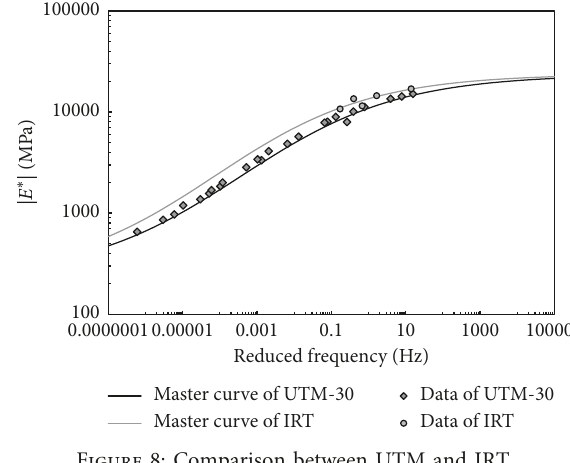
Figure 8: Comparison between UTM and IRT.